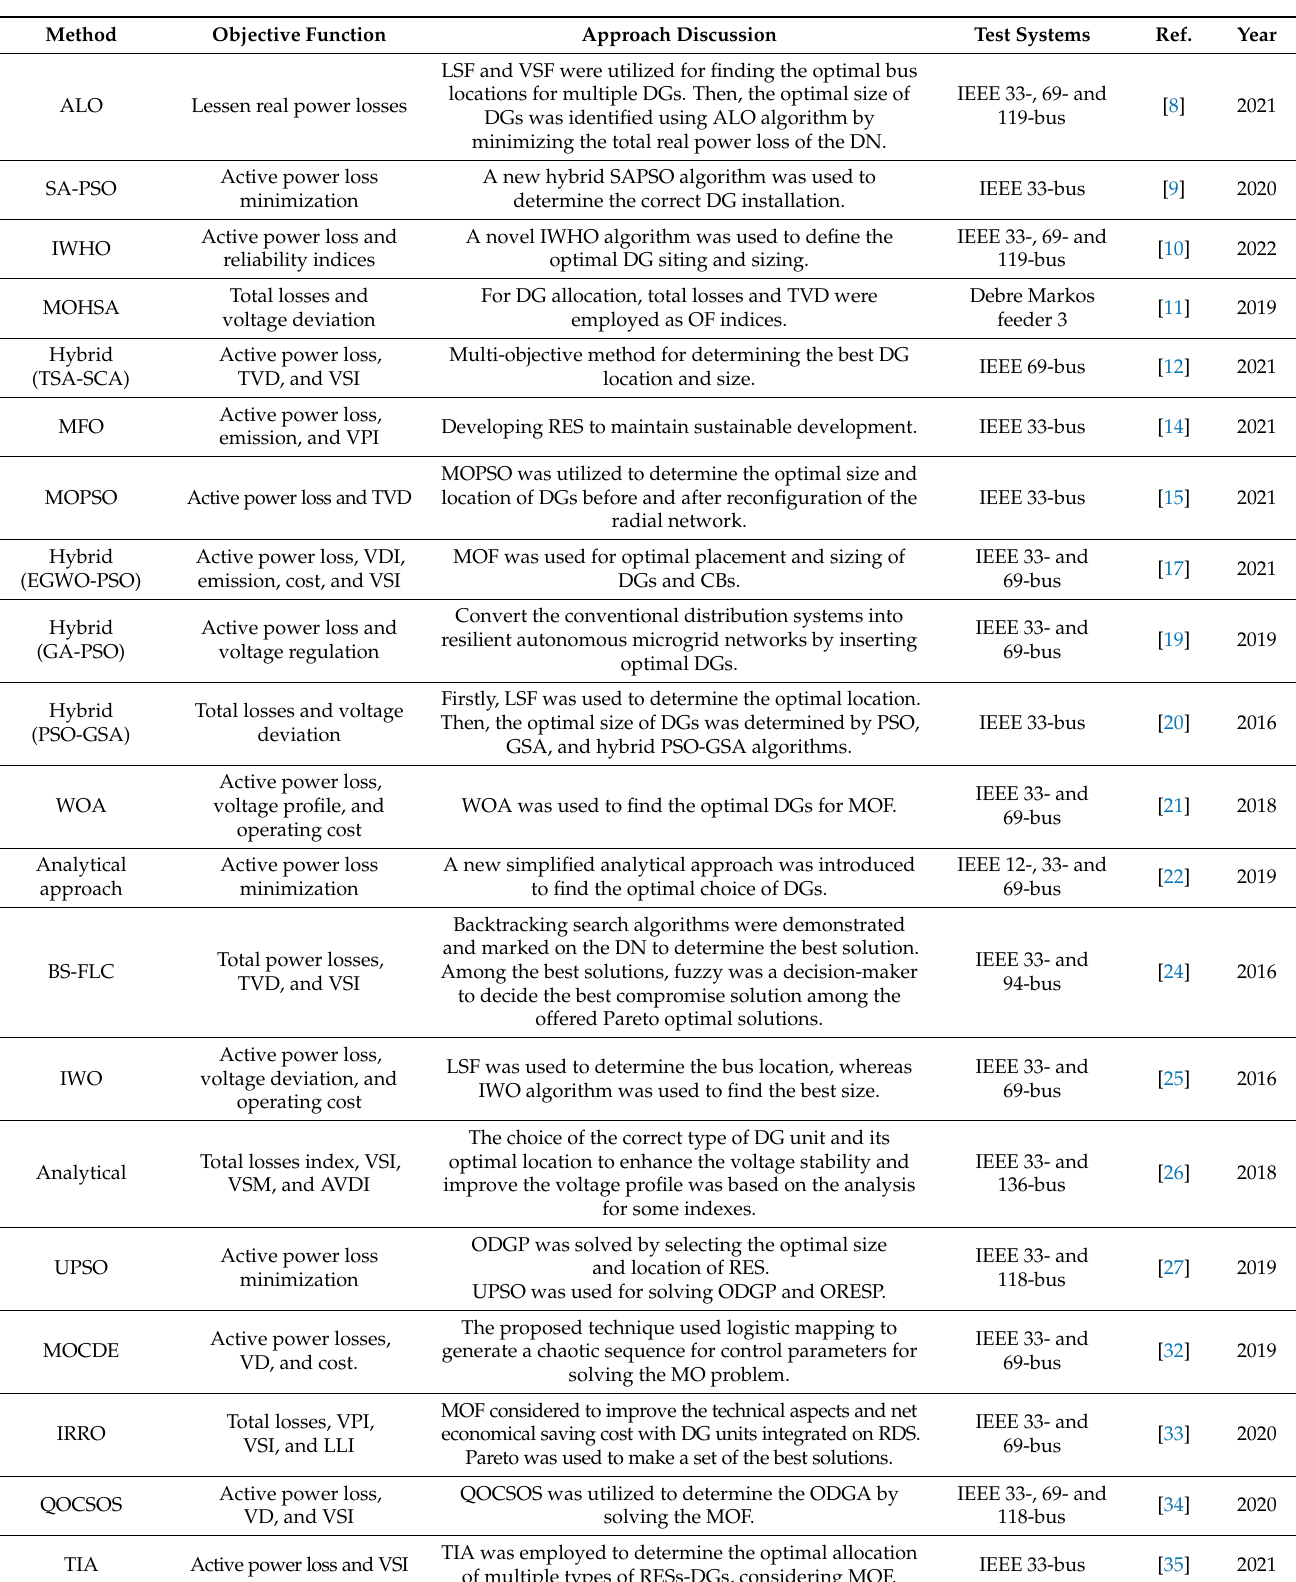
Table 1. Applied approaches for RESP